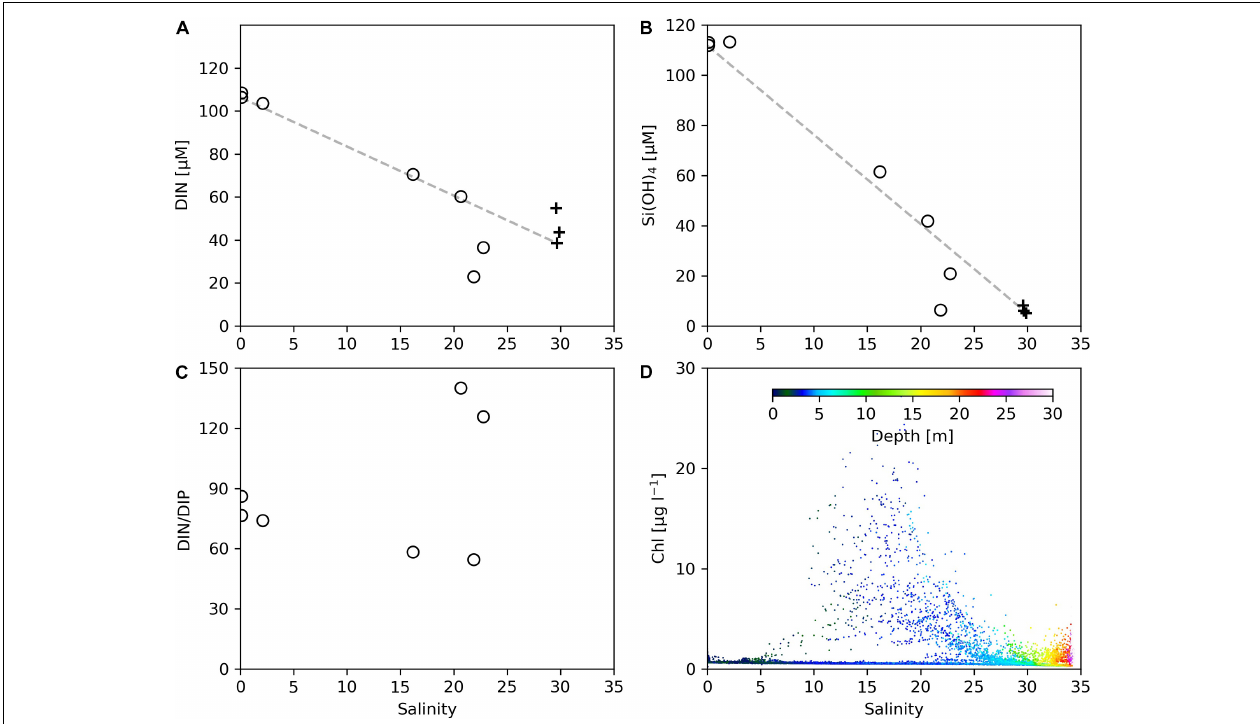
FIGURE 8 | The variations of (A) DIN, (B) Si(OH) 4 , (C) DIN/DIP, and (D) Chl concentrations as a function of salinity on Transect C2. In (A – C) , open circles denote data from our cruise, and black crosses denote data from the open research cruise. Missing black crosses at high salinity in (C) are due to low DIP values under the detection limit.